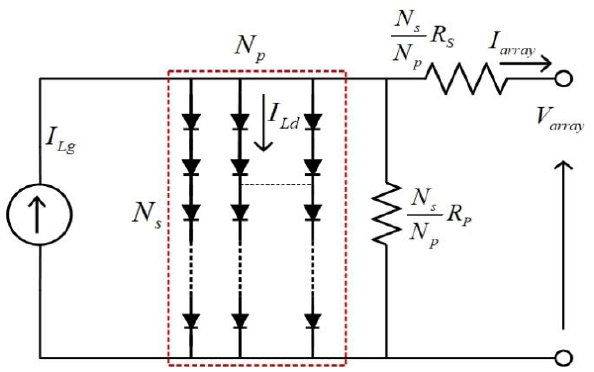
Figure 4. Equivalent circuit of PV array.